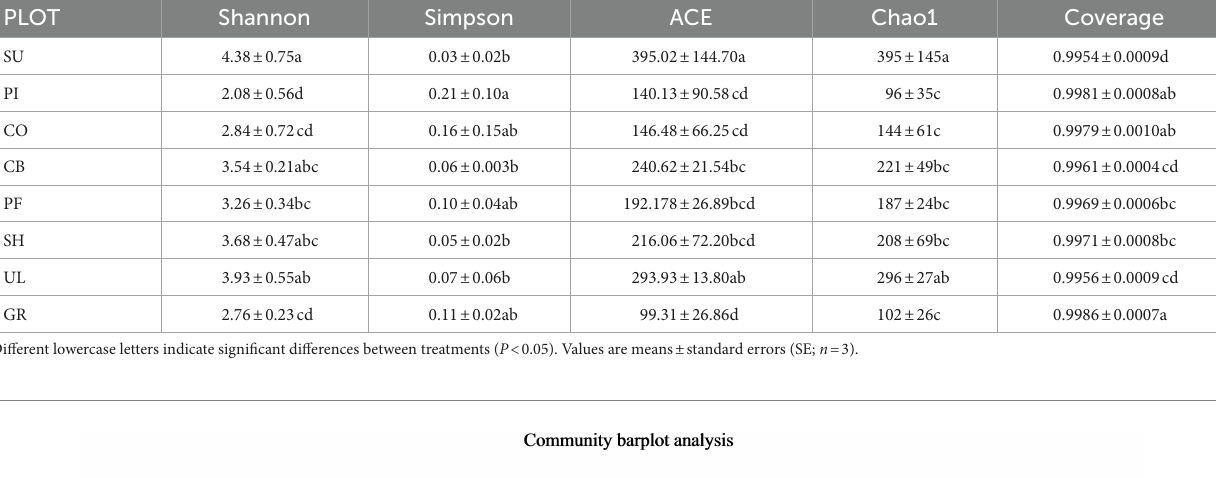
TABLE 3 AMF diversity indices for soils at different altitudes. PLOT